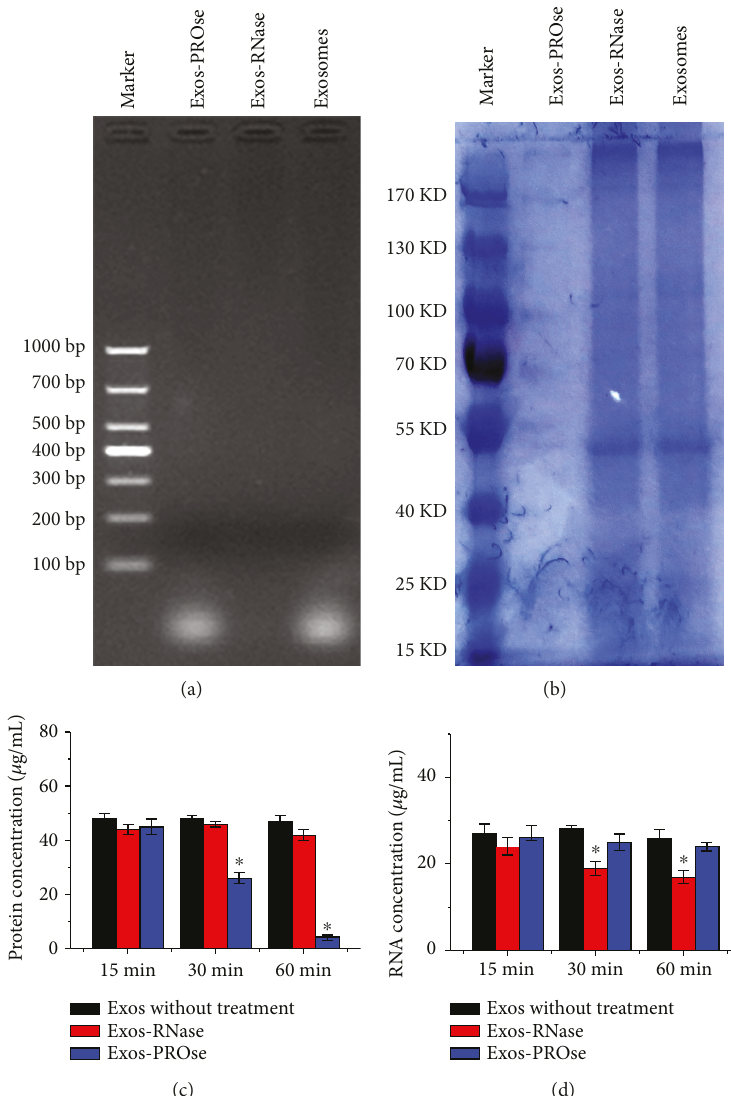
Figure 2: Characterization of puri fi ed hAEC-Exos together with either PROse or RNase treatment. (a) Gel electrophores show that exosomes were depleted of RNAs after RNase digestion. (b) Coomassie blue staining shows that proteins were thoroughly degraded after PROse treatment ( n = 3 ). (c) Detection of protein concentration by the BCA protein assay kit and RNA content (d) by the spectrophotometric ratio ( ∗ P < 0 05 , n = 3